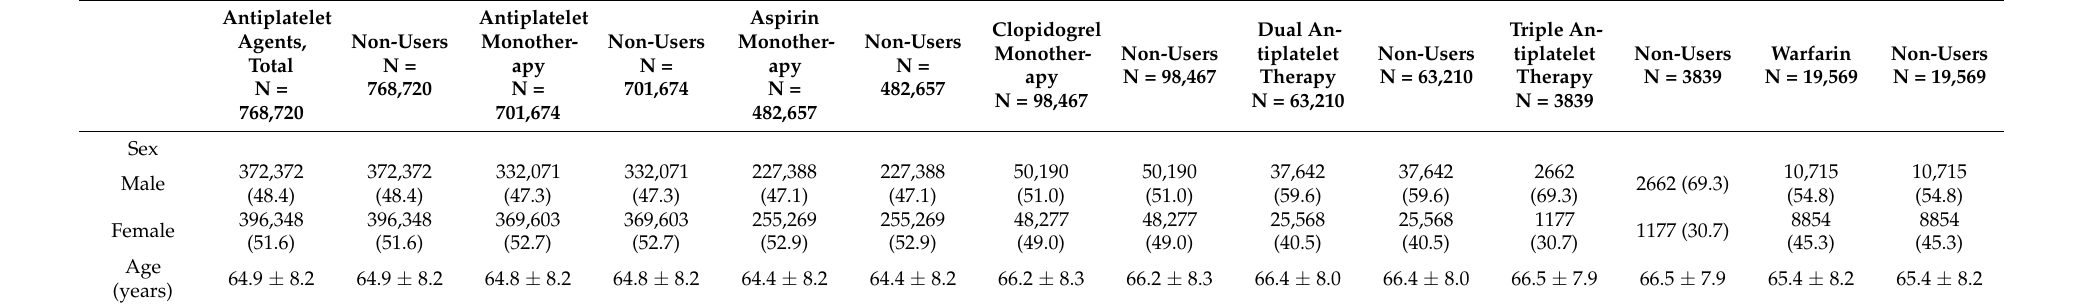
Table 2. Baseline characteristics in the 1:1 matched population.